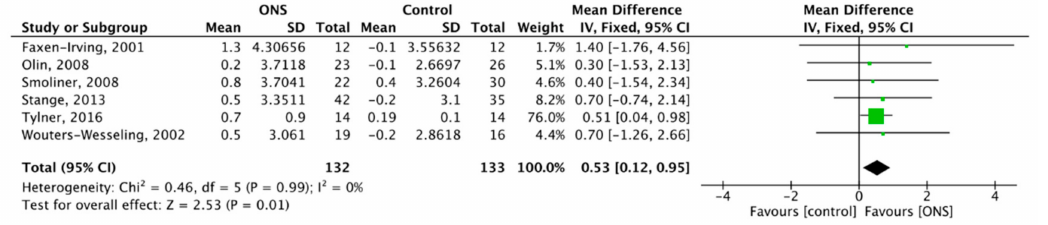
Figure 11. Forest plot comparing the effect of ONS on